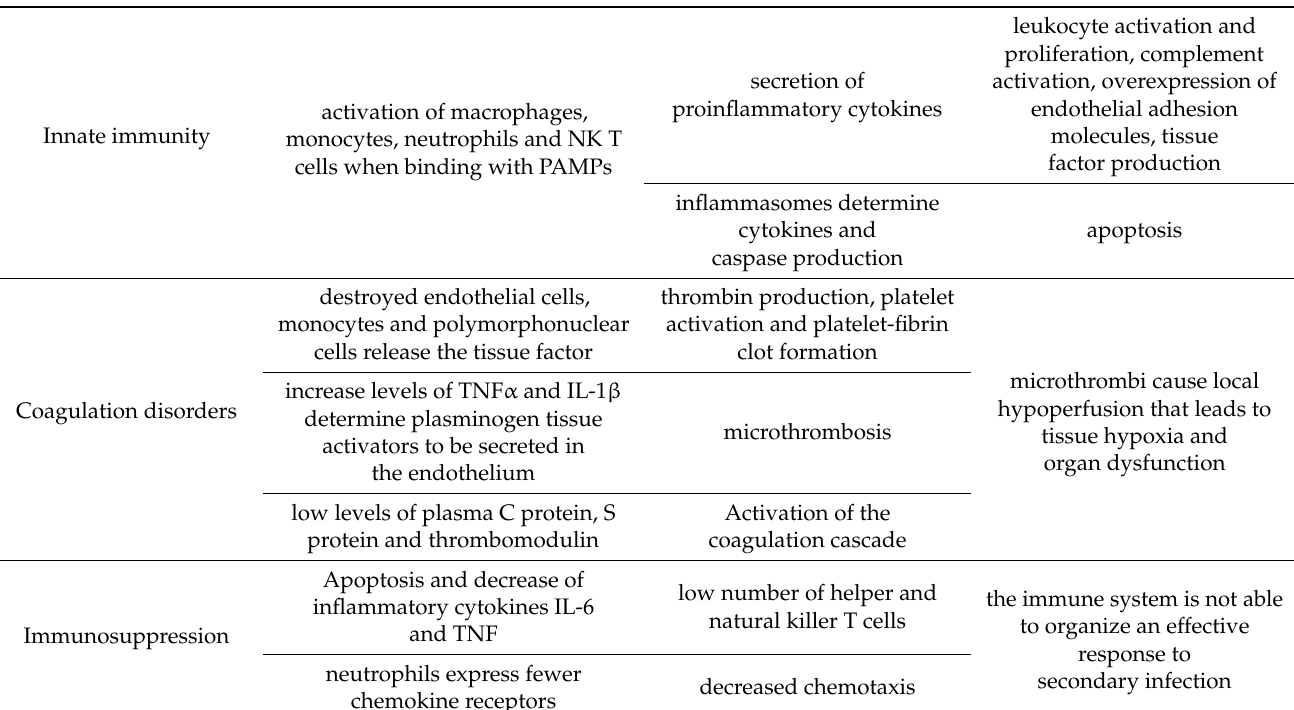
Table 1. Pathophysiology in urosepsis. Inflammatory mediators and their